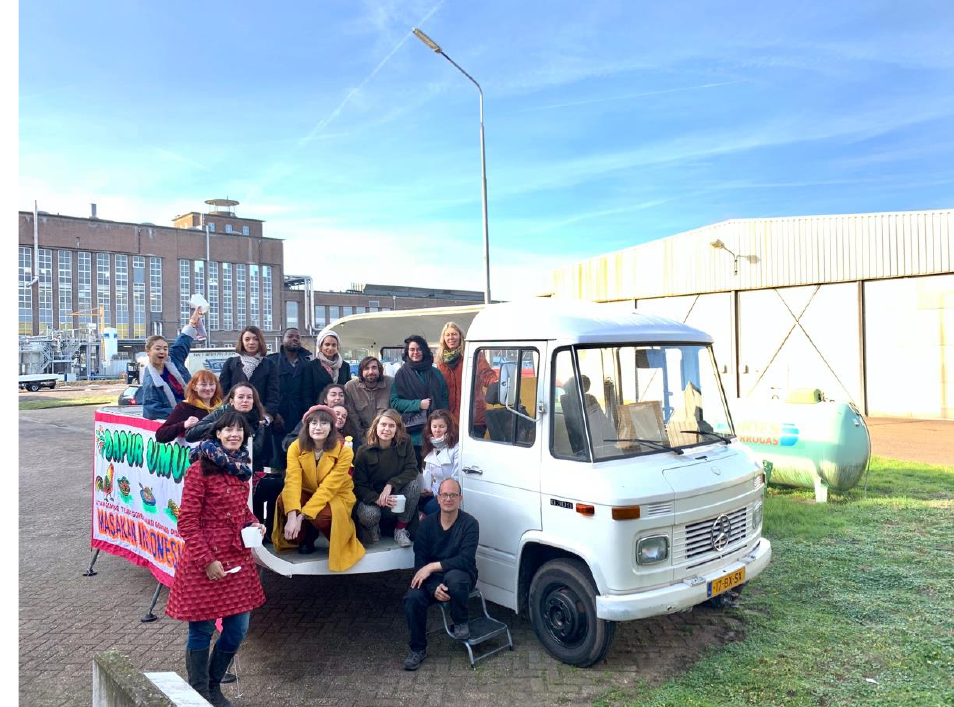
Figure 3. iMAE students during a studio visit with artist Kevin van Braak, Arnhem, NL. In this case, when the Arte Ú til archive infiltrated the classroom, rubbing alongside the modern narratives of art and artistic practice, it triggered a series of debates that fos- ters a critical learning ecosystem linking theory and practice. The archive became an edu- cational tool creating multiple constellations of projects that act as catalysts for discussing local issues and international struggles, whilst at the same time provoking dialogue and analysis around the notion of art and the modern paradigm. The most immediate feed- back from the cohort could be seen in students’ additions to the curriculum. They brought up relevant issues linked to their different backgrounds, geographical contexts, or re- search interests. Reflecting on that, the students generally expressed that the array of ma- terials, case studies, themes, and subjects presented in class helped them to critically ana- lyse the subject of their study. Another aspect worth mentioning is the use of the Arte Ú til criteria together with the key words included in Toward a Lexicon of Usership (Wright 2013). Both the criteria and some specific words were instrumental for reflecting upon charac- teristics and contradictions of the practice. Furthermore, in order to merge the speculative approach with the practical one, the programme included theoretical exercises, work- shops, embodied activities, and tools that activate some of the concepts discussed during the sessions such as the “Coefficient of Art”. The latter exercise in particular helped the comprehension of a fundamental principle in both a practical and physical manner. For it, students were encouraged to think about the “amount of art” in their practice, how it evolves and relates to other disciplines. This link between their projects with other fields helps to shift the reflection from what should be perceived as art to rather trying to define what art means with respect to their work. Another device that was proposed to the cohor t of students was the “Asociación de Arte Útil Mapping Tool”. The tool consists of a tea and coffee table set which includes different color-coded stickers representing value chains, connections, and relationships between the individuals and institutions that are members of the Asociación. Its initial